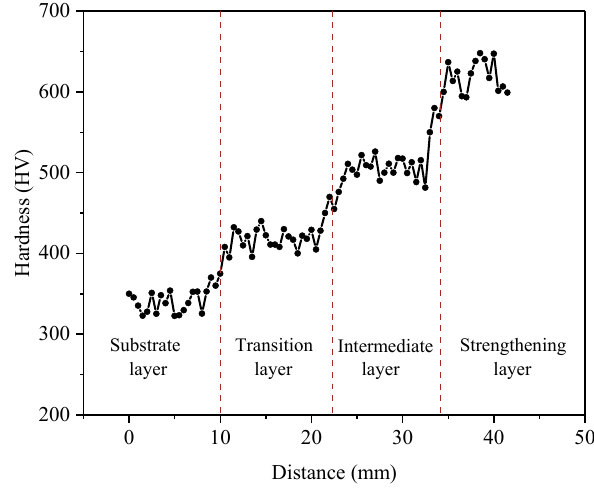
Figure 10. Microhardness distribution of the GAL.